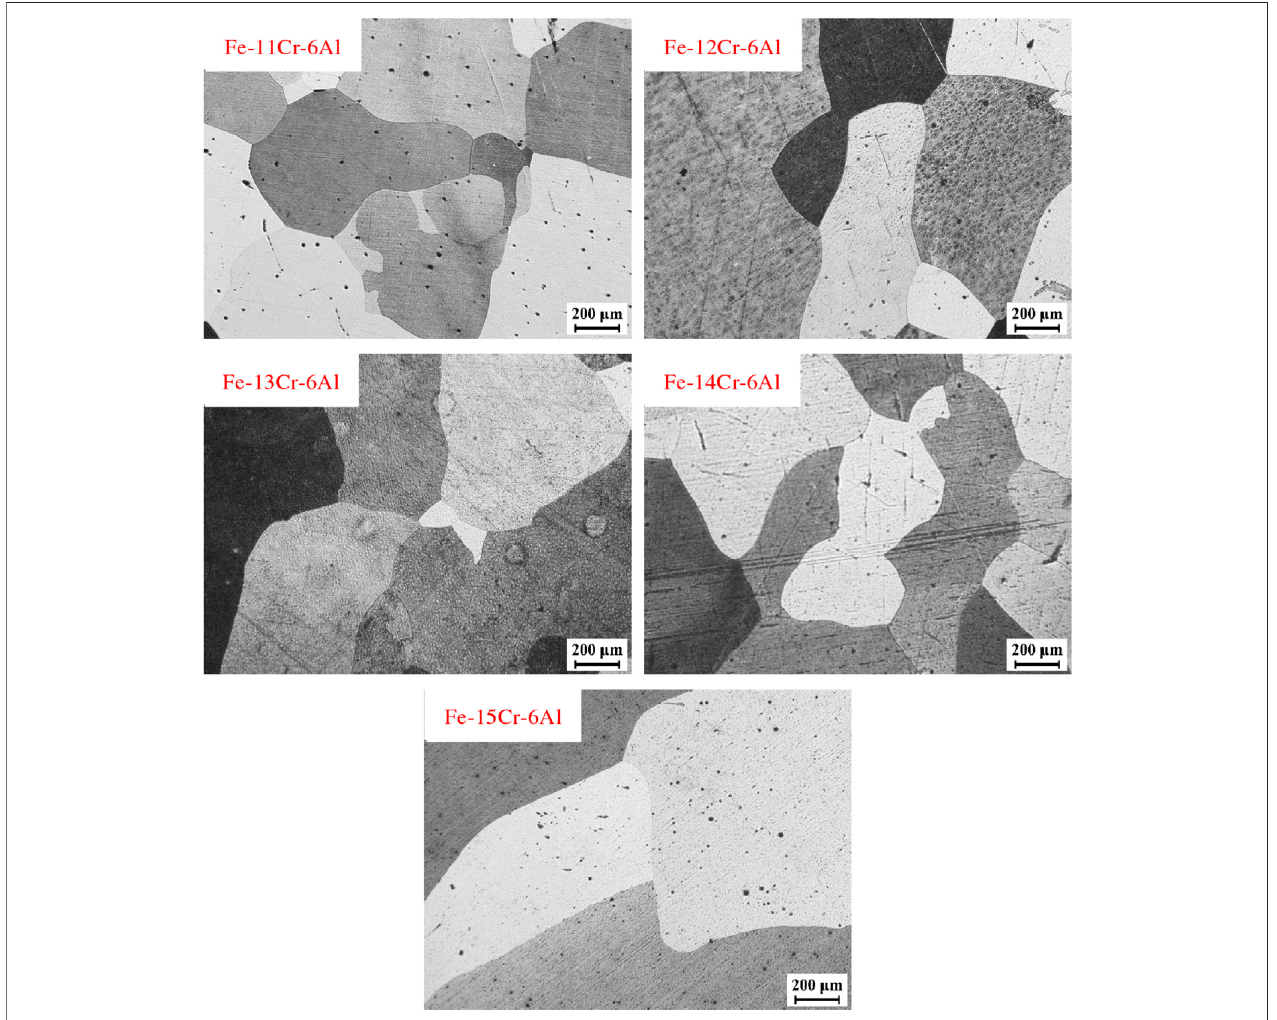
FIGURE 6 | Recrystallization and annealing structure of Fe – x Cr – 6Al alloys with different Cr content after rolling.